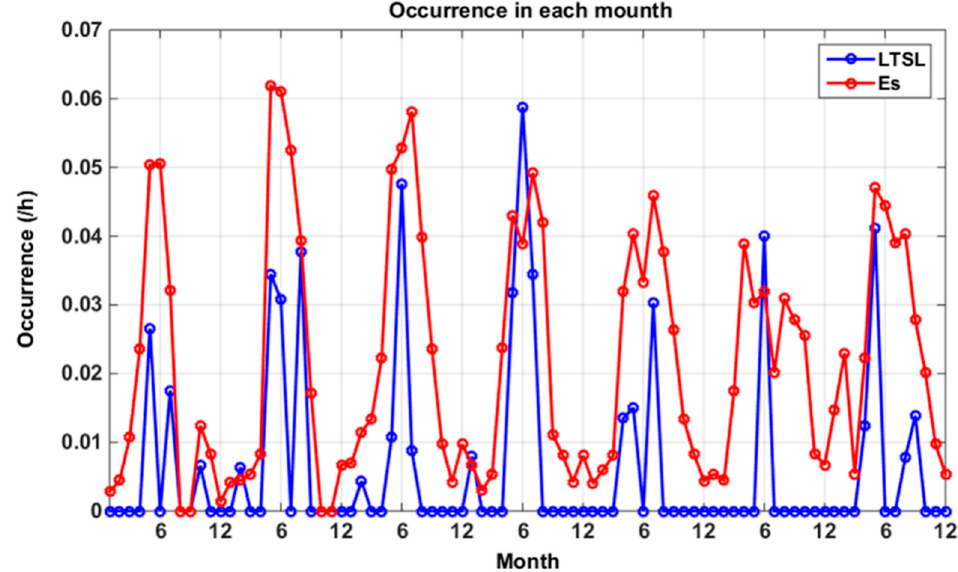
Figure 5. The monthly occurrence rates of LTSLs and Es (occurrence rates = the number of LTSL or Es in each month/the total observational time in each month).